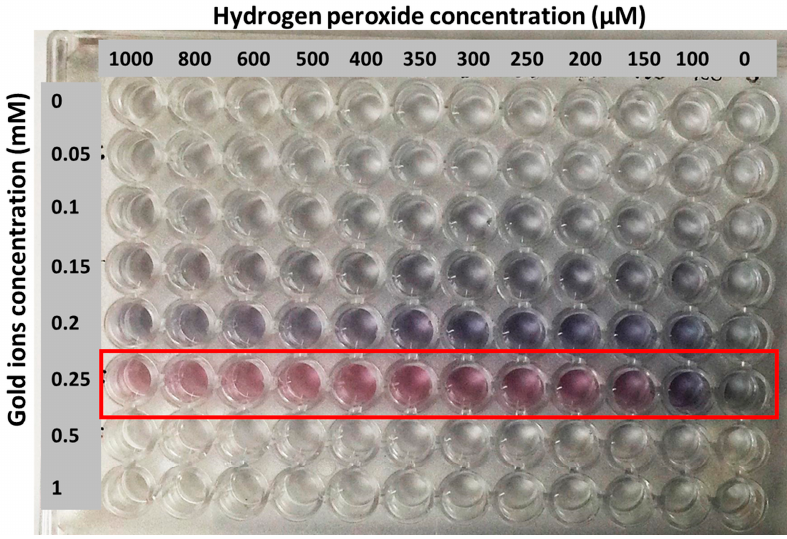
Figure 4. Generation of nanoparticle solutions with different colors depending on the concentration of hydrogen peroxide and gold ions.